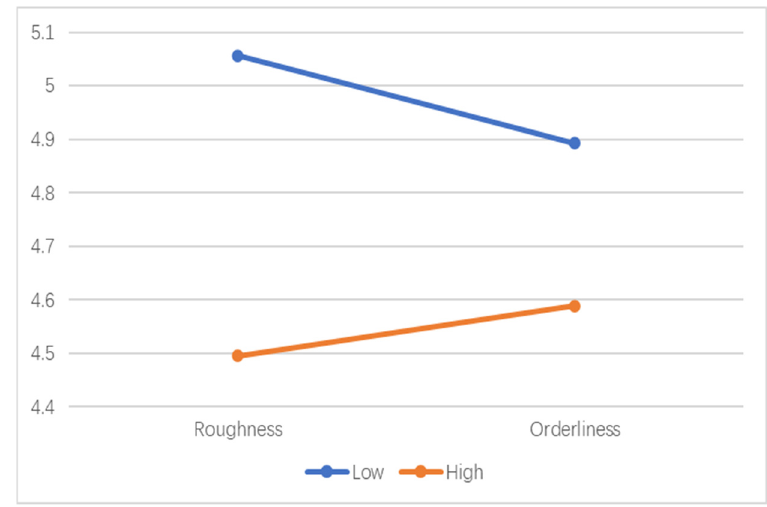
Figure 5. Mean value of concave/convex degree classification.